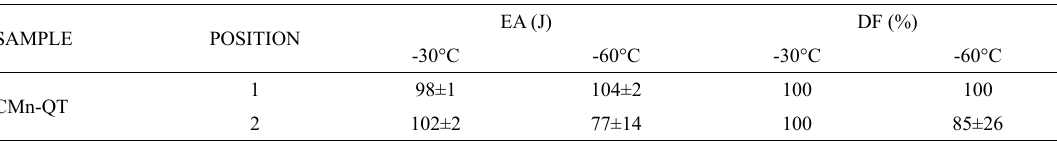
Table 4. Charpy impact properties of the C-Mn